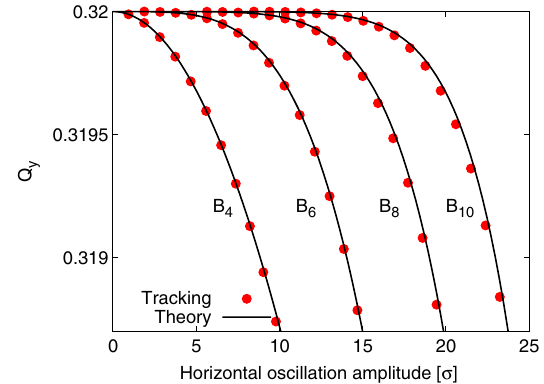
FIG. 2. Cross term of amplitude detuning for a single multi- pole of order 2 n . The red dots are the result of the tracking and the black lines are the theoretical predictions for an ac dipole excitation (equal to the free oscillations term).